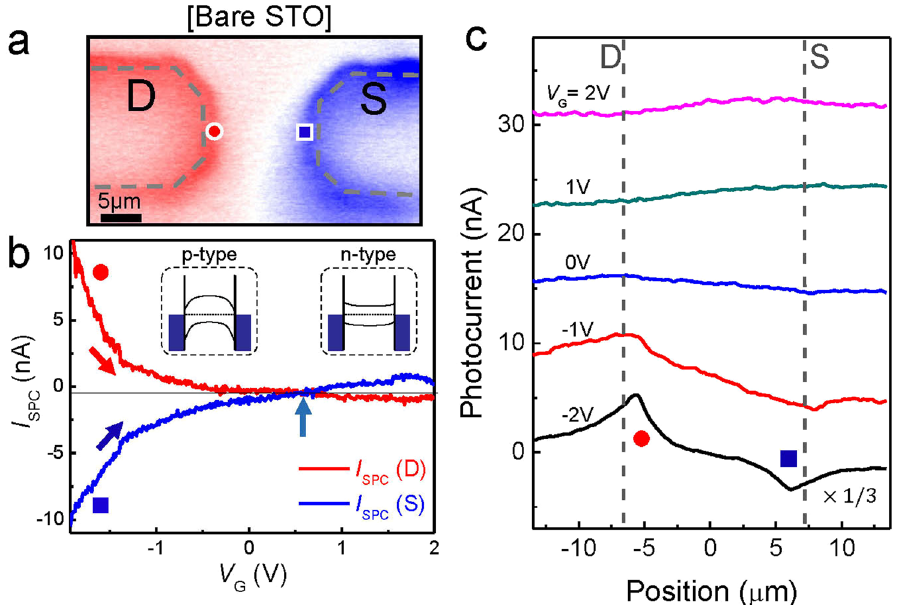
Figure 2. ( a ) SPCM of a bare STO device at V SD = V G = 0 ( b ) Photocurrent as a function of V G near the drain (red) and source (blue) electrodes. (inset) Schematic band diagrams of STO device for p-type (left), and n-type (right) operation. ( c ) Photocurrent profile as a function of position for various V G ’s. The curves are offset for